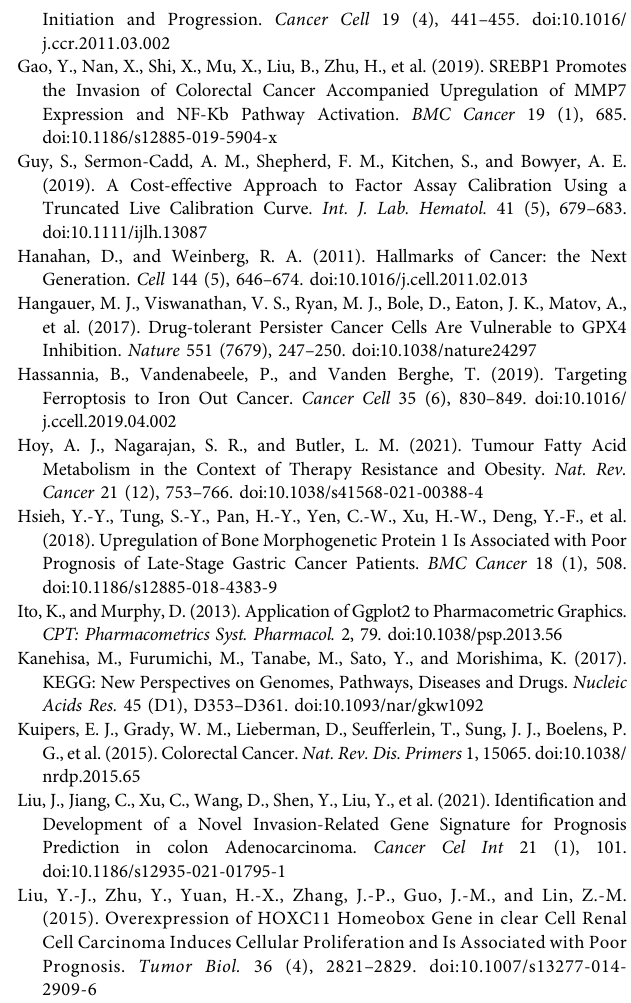
Supplementary Figure S2 | The basic characteristics of invasion and migration related gene: PCOLCE2, HOXC11 ROC analysis of PCOLCE2 (A) and HOXC11 (E) indicates the diagnosis and prediction of COAD; Boxplots showing the relative expression of PCOLCE2 (B,D) in COAD patients by lymph node metastasis, T and M tumor stage, and peritoneal metastasis, respectively; Boxplots showing the relative expression of HOXC11 (F,H) in COAD patients by lymph node metastasis, T and M tumor stage and peritoneal metastasis, respectively. Supplementary Figure S3 | Prediction abilityoftwo intersected genes:PCOLCE2, HOXC11 The establishment of nomogram model with clinical factors, and expression of PCOLCE2, HOXC11 (A) . Time ROC analysis of PCOLCE2, HOXC11 in 1, 3, 5 year survival time (B,C) . univariate and multivariate cox analysis of the potential targeted genes, PCOLCE2, HOXC11 (D,E) . Supplementary Figure S4 | Functional enrichment analysis of positively correlated genes of targeted genes Heat map of positive correlated gene of PCOLCE2 (A) and HOXC11 (B) ; Go enrichment analysis of positively correlated genes (C) , including Biological Process (BP) analysis, Cellular Components (CC) analysis, Molecular Function (MF) analysis; Visualization for KEGG pathway enrichment analysis of positively correlated genes (D) ; PPI network interaction analysis of positively correlated genes (E) ; Screening of hub gene (F) . Supplementary Figure S5 | Representative immunohistochemistry staining of predicted hub gene The protein expression levels of PCOLCE2 (A) , ITGAM (B) , TYROBP (C) , CD33 (D) , HOXC11 (E) , ITGAX (F) , FCER1A (G) , FCER1G (H) in normal individuals or COAD